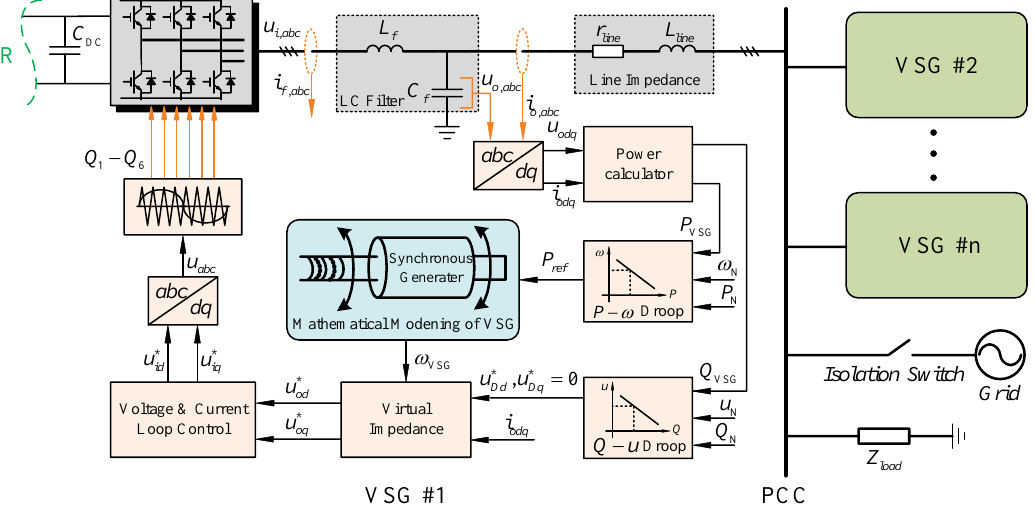
Figure 5. Structure of the multiple parallel VSGs system.